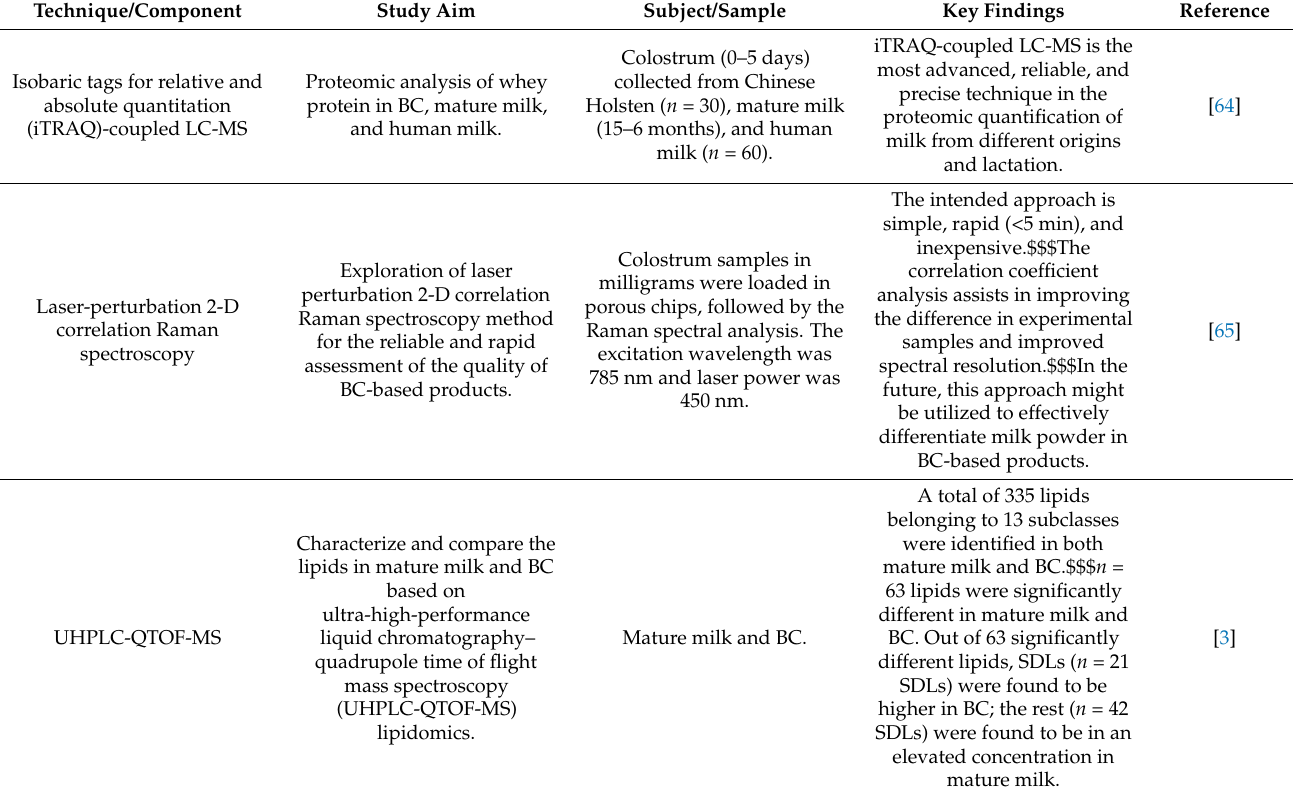
Table 2. Modern techniques employed in the isolation and identification of BC